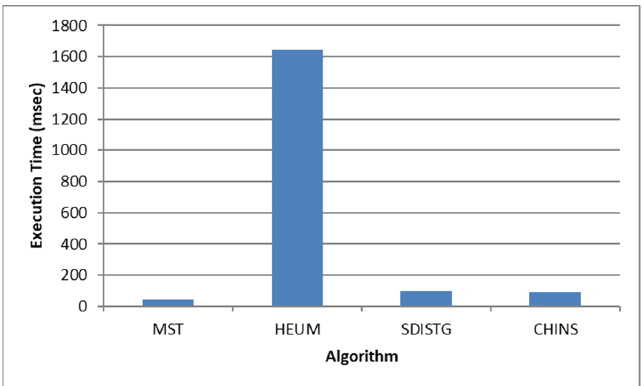
Figure 11. The average execution times for the various algorithms for linking the selected top-k nodes on DBpedia v3.8 (ms).